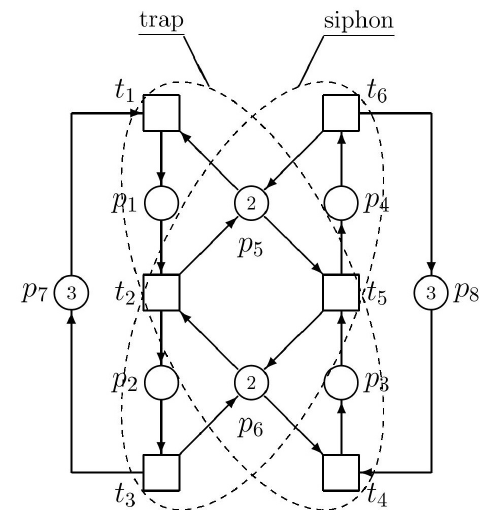
Figure 4. The siphon S and trap T in the PN